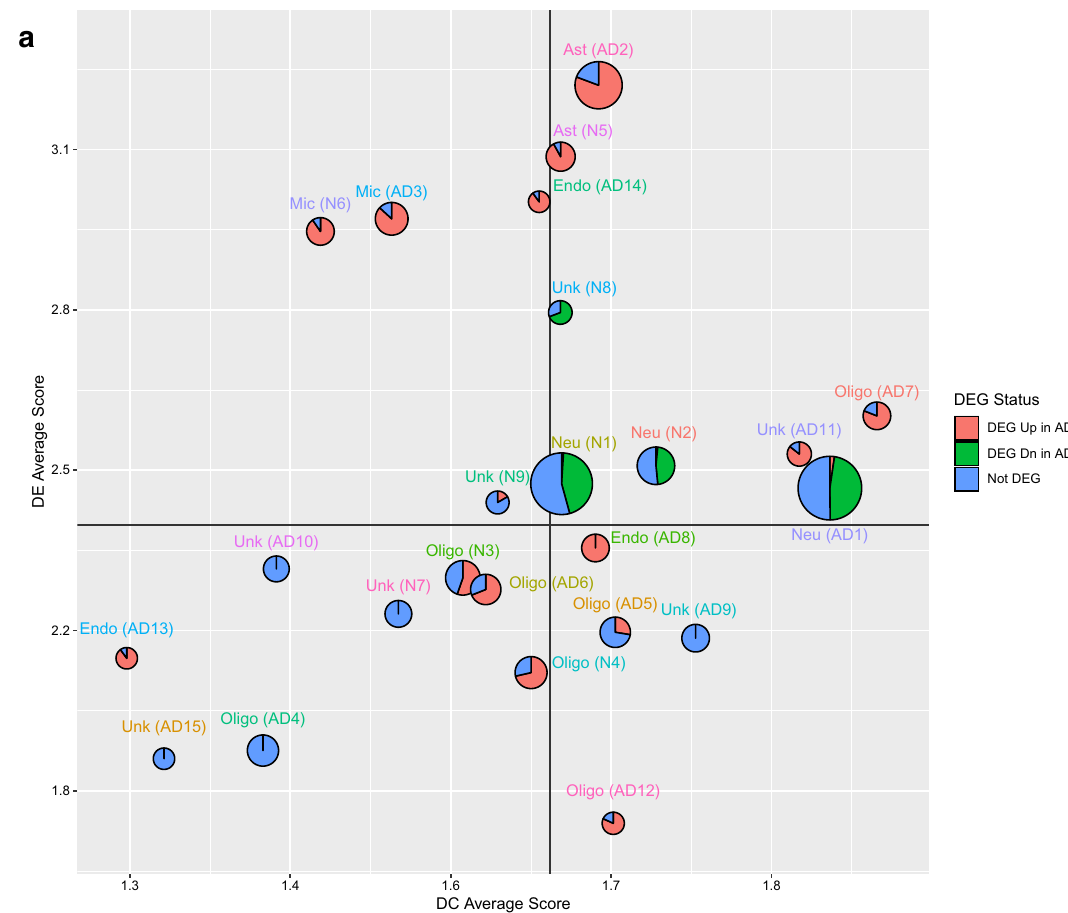
Figure 1. FGCN modules from AD and control samples classified according to differential expression and co-expression levels. ( a ) Differential expression average scores (DE) vs. differential co-expression average scores (DC) of 24 frequent gene co-expression network modules (module names in parenthesis), the majority of which are enriched with specific biological functions as shown in panel b. Most of the modules are also enriched for specific cell-type markers: Neu, neurons; Ast, astrocytes; Mic, microglia; Endo, endothelia; Oligo, oligodendrocytes; Unk, modules not enriched with cell type-specific markers. The pie charts indicate the proportions of differentially expressed genes (up or down in AD vs. control) in the modules. ( b ) The top two enriched biological functions/processes/pathways in each module identified using ToppGene. The colors of the bars are indictive of different biofunctional terms. ( a ). ( c ) A heatmap of the degree of overlap between the genes in each pair of modules mined from the AD and control samples. The modules were rearranged by their similarities and then plotted according to the Jaccard Index values. ( d ) Cell-type enrichment for each module was assessed by cross-referencing the module genes against cell-type signatures of neurons, microglia, astrocytes, oligodendrocytes, and endothelial cells. The x-axis shows the different modules. The 24 FGCN modules are numbered as: 1–15 correspond to modules AD1 to AD15; 16–24 correspond to modules N1 to N9. The significance of the cell-type enrichment in the modules was measured by Fisher’s exact test and corrected for multiple comparisons by the Benjamini and Hochberg procedure. Horizonal blue lines indicate the threshold of false discovery rate 0.05. There is no color match between panels ( a , d